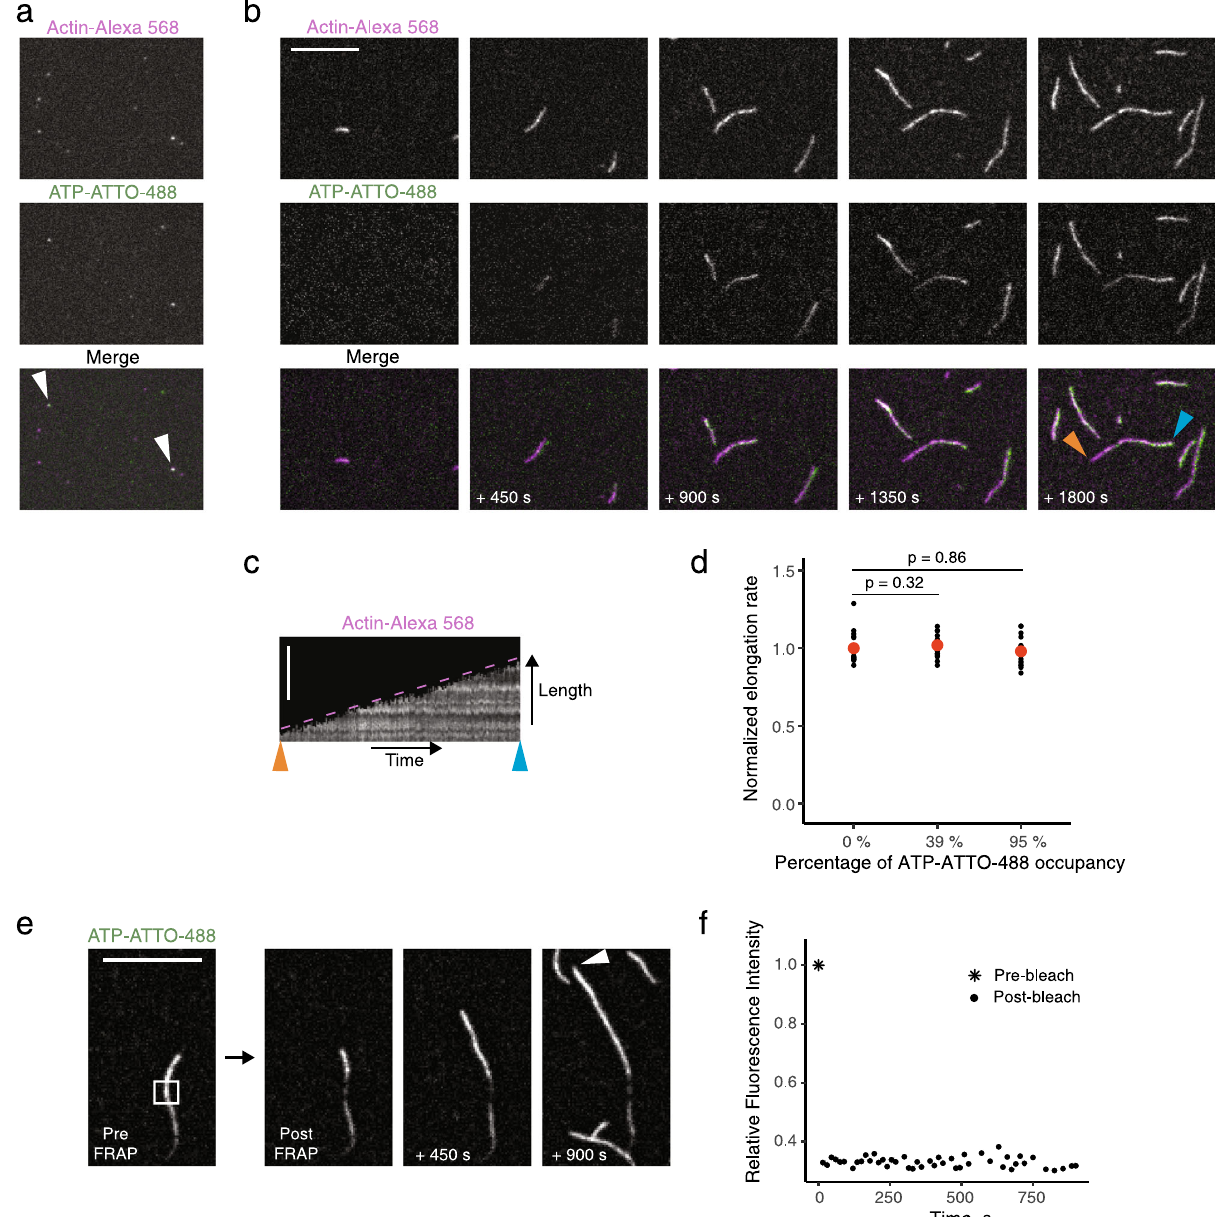
Fig. 3 Single-molecule imaging of ATP-ATTO-488 bound to G-actin and actin fi laments by total internal fl uorescence microscopy (TIRFM). ATP adenosine triphosphate, FRAP fl uorescence recovery after photobleaching. Scale bars: 10 µ m. a Single-molecule imaging of individual ATP-ATTO-488 molecules (green) and Alexa-568-labeled G-actin (magenta). Prior to imaging, ATP-ATTO-488 (0.2 µ M) and G-actin (2 µ M; 7.5% labeled) were pre- incubated for exchange for 15 min in NFG + MEI buffer before a 10 5 -fold dilution in imaging buffer 1 to isolate single molecules. White arrowheads highlight visible binding. This experiment was repeated independently three times. b Time-course of a simultaneous exchange of ATP-ATTO-488 (0.25 µ M; green) and polymerization of actin (0.4 µ M; 7.5% Alexa-568-labeled; magenta) in the presence of pro fi lin (0.8 µ M) in imaging buffer 2. Blue and orange arrowheads indicate the barbed and pointed ends, respectively, of an actin fi lament, which assembled exclusively from ATP-G-actin monomers at early timepoints, before integrating progressively increasing numbers of ATP-ATTO-488-bound actin subunits. This experiment was repeated independently three times. c Filament length vs. time kymograph of the fi lament indicated with blue and orange arrowheads in b . Dotted line shows that slope appears constant over time. d Elongation rates of actin fi laments polymerized from actin monomers bound to 39% or 95% of ATP-ATTO-488, relative to their elongation rates when bound fully to ATP, indicating that actin subunits bound to ATP-ATTO-488 do not visibly impact actin polymerization. 0, 5 µ M, or 125 µ M of ATP-ATTO-488 were pre-incubated with 5 µ M actin (10% Alexa-568-labeled) for 2 h at room temperature in NFG buffer to reach respectively 0%, 39%, or 95% occupancy. Polymerization was then induced between slides and coverslips by 5-fold dilution in imaging buffer 2 supplemented with 3 µ M pro fi lin. Red dots indicate average values. n = 20. Statistical signi fi cance is given with p -values from one-factor ANOVA tests. e Photobleaching of a segment of an actin fi lament labeled with ATP-ATTO-488 demonstrating absence of fl uorescence recovery within 900 s, providing evidence that nucleotide exchange does not occur in fi lamentous form of actin. White arrowhead indicates the growing barbed end. This experiment was repeated independently three times. f Quanti fi cation of d . Source data are provided as a Source Data fi